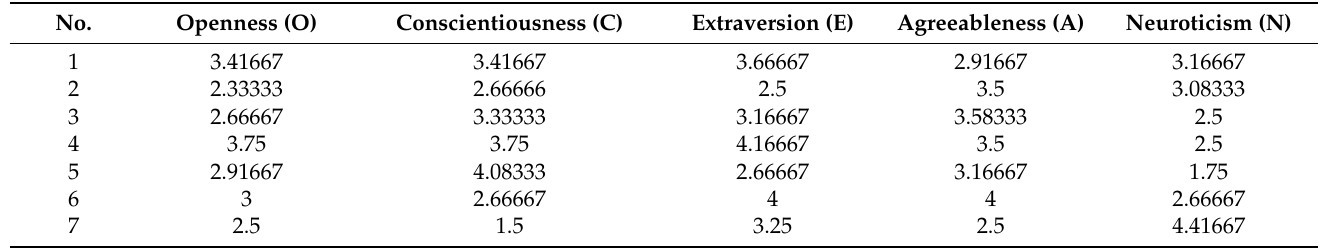
Table 2. Effective cases of the user OCEAN(Openness, Conscientiousness, Extraversion, Agreeable- ness, and Neuroticism) personality